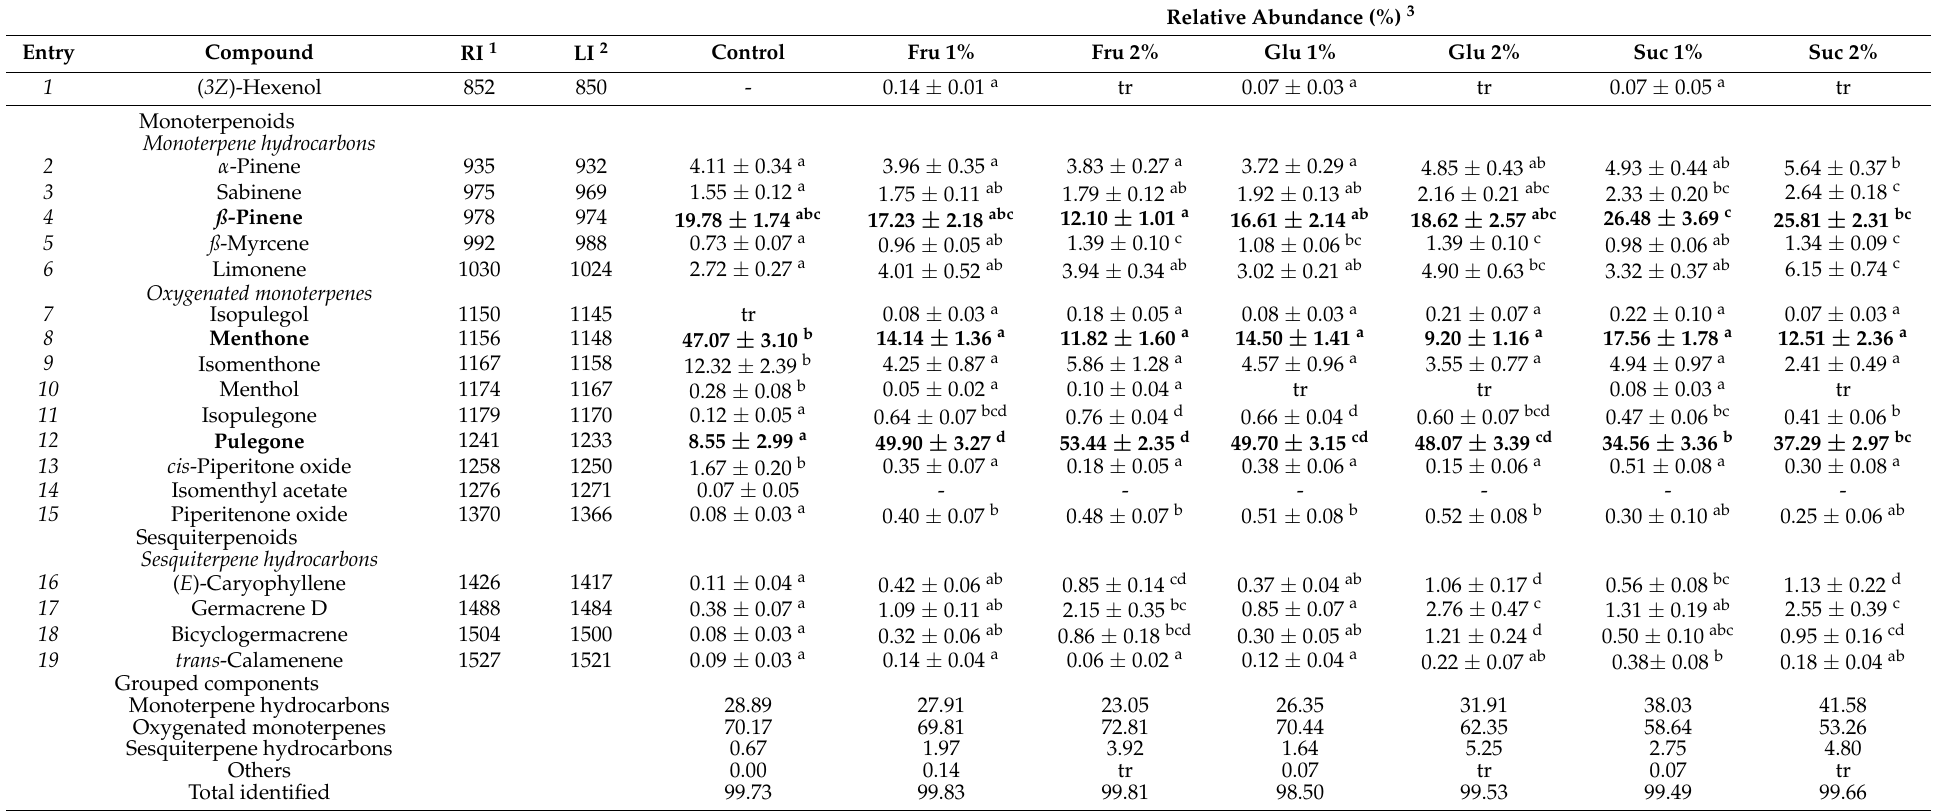
Table 1. Relative percentage composition of HS volatiles of Clinopodium pulegium shoot cultures grown on media supplemented with different carbon sources. Relative Abundance (%)